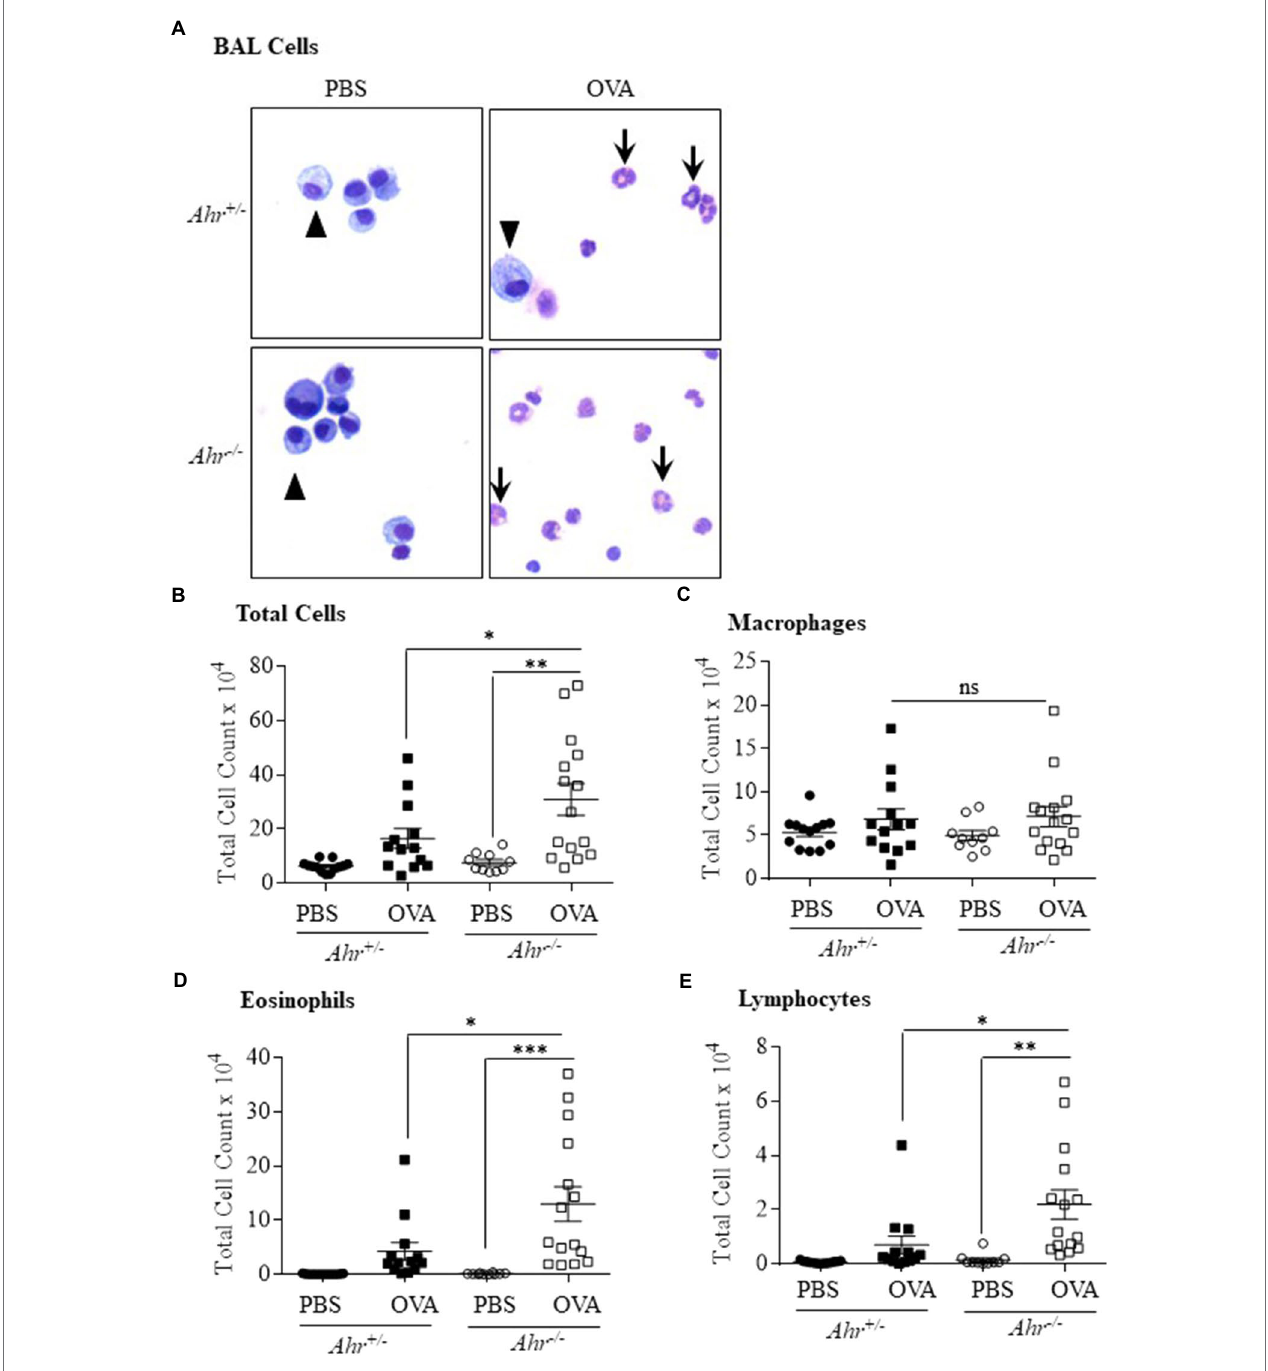
FIGURE 1 | Aryl hydrocarbon receptor (AhR) reduces ovalbumin (OVA)-induced airway inflammation. (A) Bronchoalveolar lavage (BAL) cells – presence of macrophages (arrowheads) in the BAL as the predominant cell type in PBS-exposed mice. There were more eosinophils (arrows) in the OVA-exposed Ahr − / − as well as Ahr+/ − mice. (B) Total Cells – there was a significant increase in total cells in Ahr − / − mice exposed to OVA (** p = 0.001 OVA compared with PBS; * p = 0.0451 OVA-exposed Ahr − / − mice vs. OVA-exposed Ahr+/ − mice). (C) Macrophages – there were no significant differences in macrophages numbers between the Ahr − / − and Ahr+/ − exposed to OVA. (D) Eosinophils – there was a significant increase in eosinophils in OVA-exposed Ahr − / − mice compared with both PBS control (*** p = 0.0005) as well as OVA-exposed Ahr+/ − mice (* p = 0.0148). (E) Lymphocytes – the number of lymphocytes in OVA-exposed Ahr − / − mice was significantly higher than in OVA-exposed Ahr+/ − mice compared with PBS control mice (** p = 0.0016) as well as OVA-exposed Ahr+/ − mice (* p = 0.018). Results are expressed as the mean ± SEM; values for individual mice from two independent experiments are